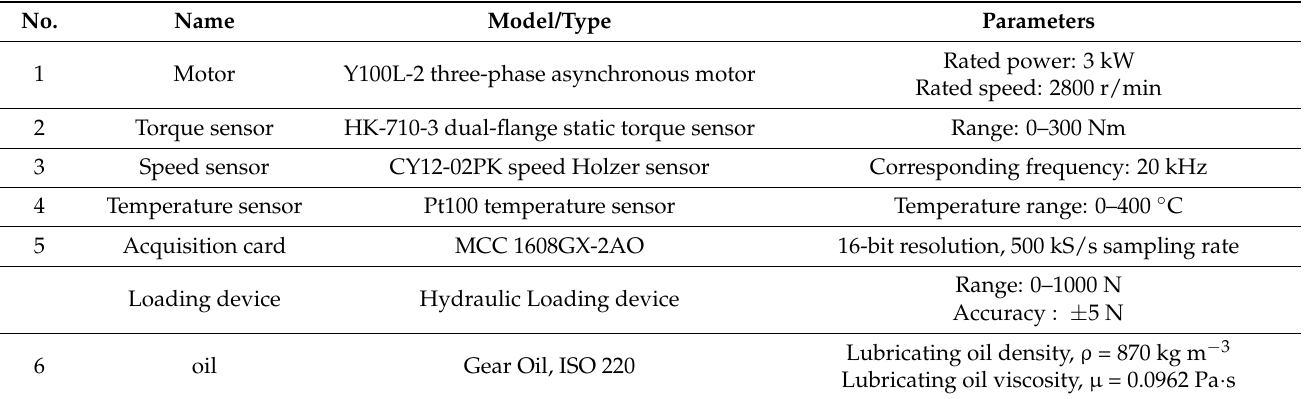
Table 1. Components of the experimental rig.